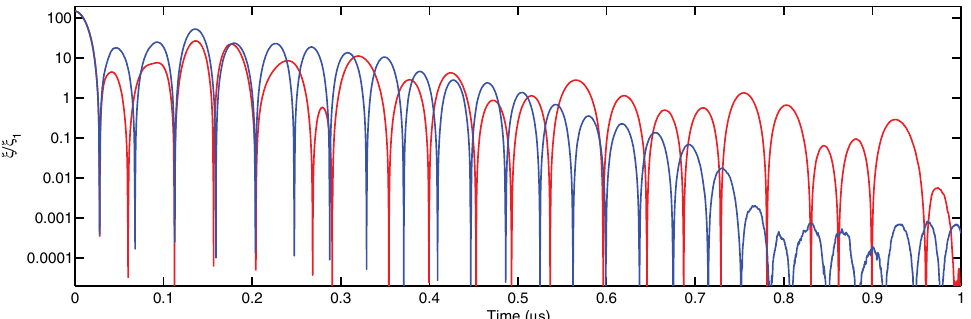
FIG. 7. Simulated homodyne signal without and with dissipation. A comparison of the homodyne dynamics (shown on a logarithmic scale, normalized to ξ 1 , the homodyne signal of a single-photon coherent state) without dissipation (red curve) and with (blue curve, averaged over 1000 walks in a quantum trajectory simulation of the master equation). The initial state is a coherent one with a mean of 150 photons on the left, no photons on the right, and the qubits in the ground state. The unitary dynamics (no dissipation) exhibits nonlinear oscillations due to the competition between intercavity tunneling and qubit coupling, in the delocalized regime not very far above N qu c . As the tunneling is less sensitive to dissipative effects, the tendency is for dissipation to linearize the oscillations. The early overshoot in the homodyne signal results from transient behavior in the initial dynamics of the